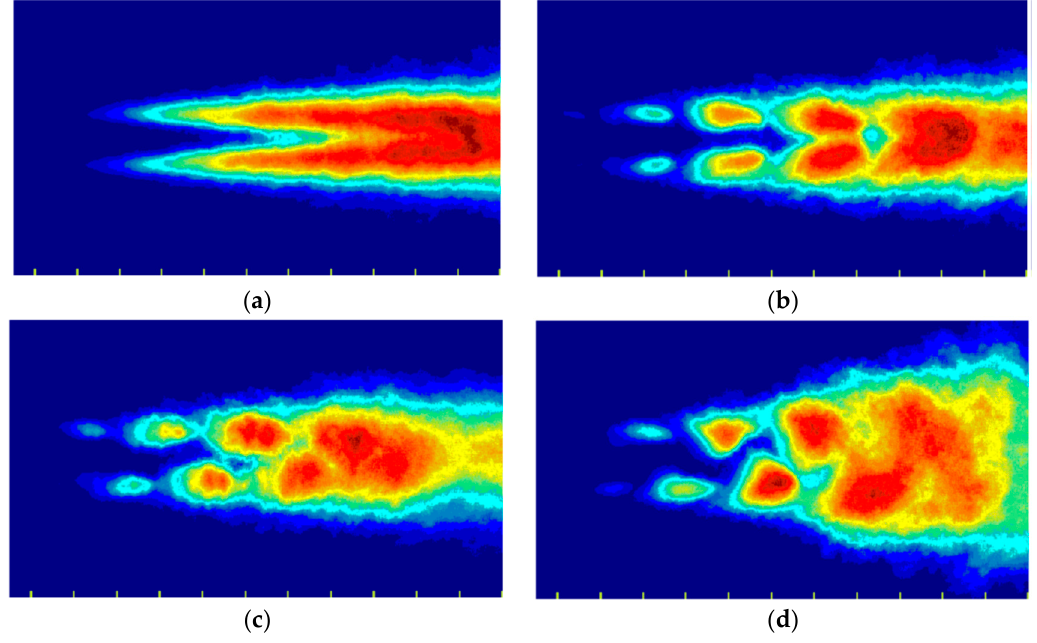
Figure 21. Phase-averaged streamwise planar images demonstrating effect of excitation azimuthal mode on LSS development for ( a ) baseline; ( b ) axisymmetric; ( c ) helical; and ( d ) flapping forcing modes [128]. Reprinted from [127] with permission from AIAA.